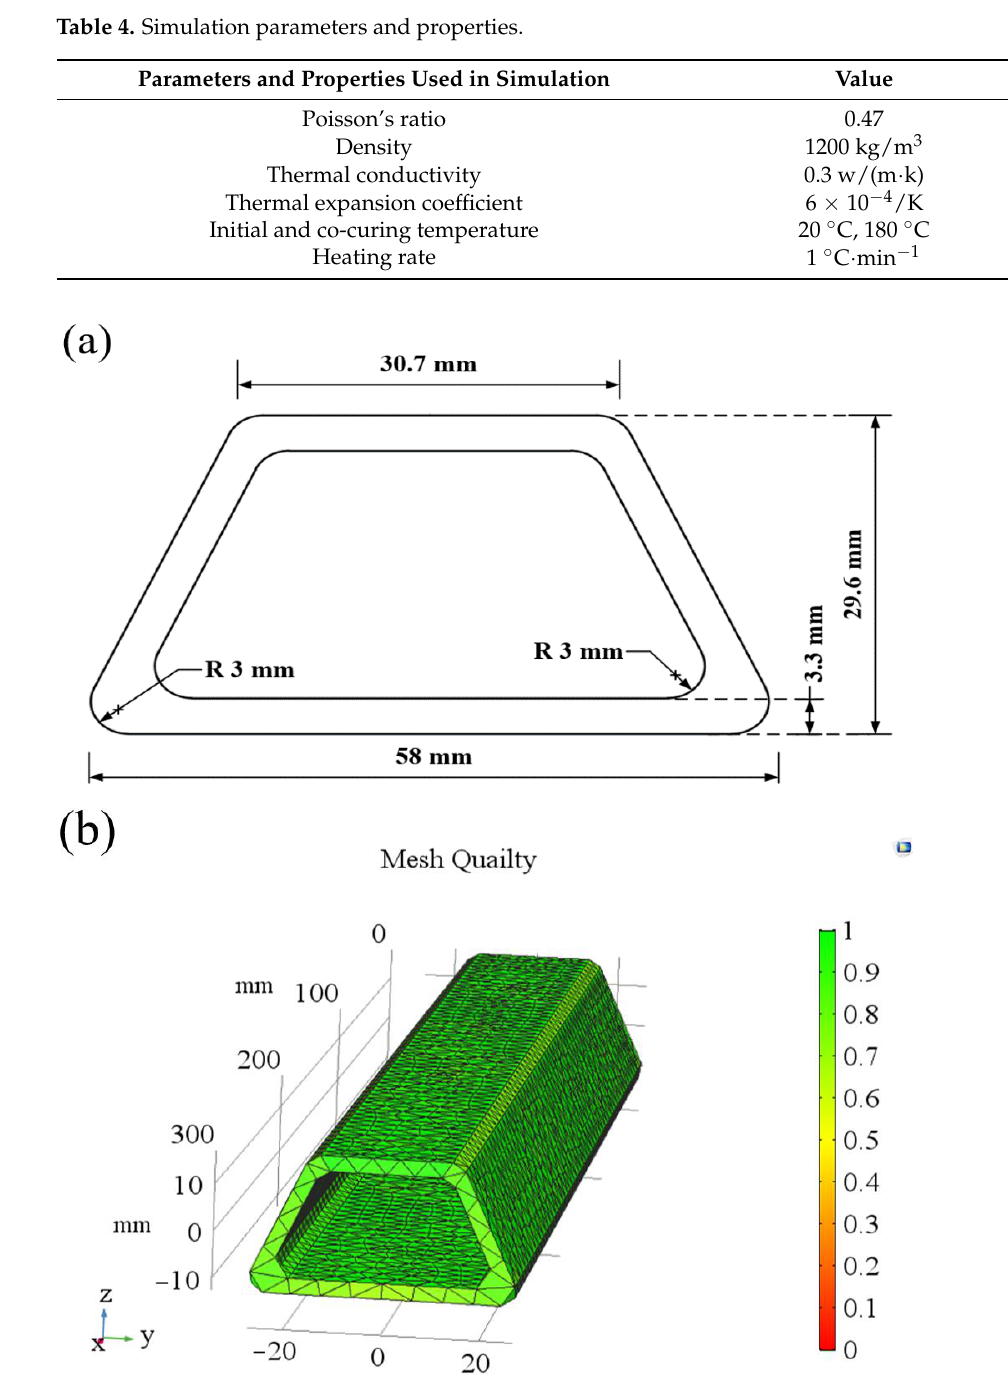
Figure 4. Dimension and mesh of silicone rubber bladder: ( a ) dimension; ( b ) mesh.